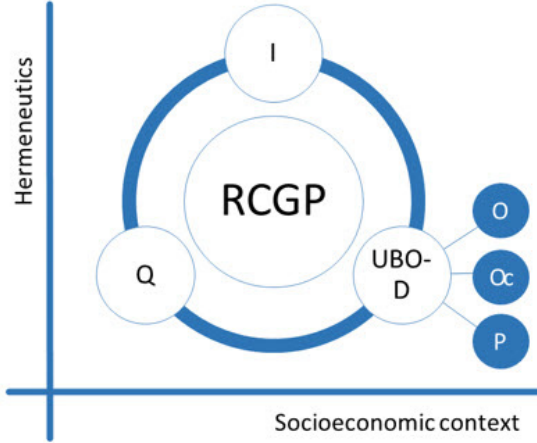
Figure 1. The RCGP model for the UBO’s Computer Engineering program.